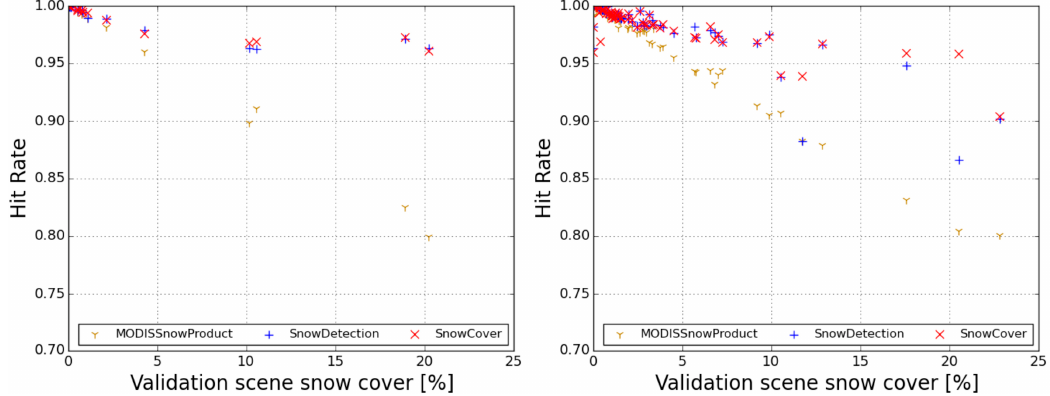
Figure 3. Comparison of MODIS standard snow product (MOD10A1) and the snow product based on MOD09GA data showing the calculated Hit Rate with respect to Landsat ( left ) and MERIS ( right ) data. The red x-marks indicate snow detection using NDSI based on MOD09GA data and the blue x-marks stand for the resultant snow cover after temporal and spatial post-processing. For comparison, the quality of the MODIS snow product (MOD10A1) is also shown (brownish x-marks).